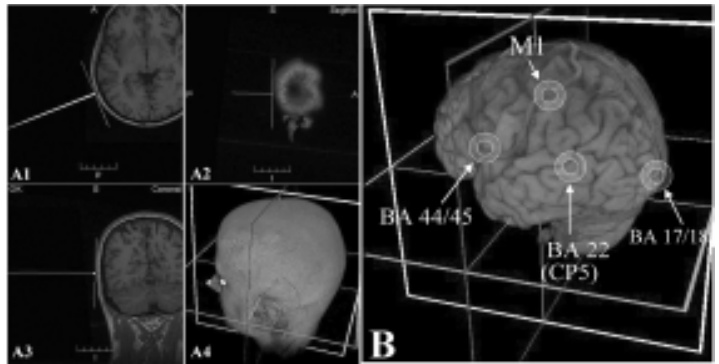
Fig. 2. Using a commercially available frameless stereotactic systems anatomical locations of CP5 and CP6, as well as the intermediate position between F5 and F7, were verified in a small subgroup of subjects to be over the posterior third of the superior temporal cortex (CP5, 6) or the inferior frontal cortex